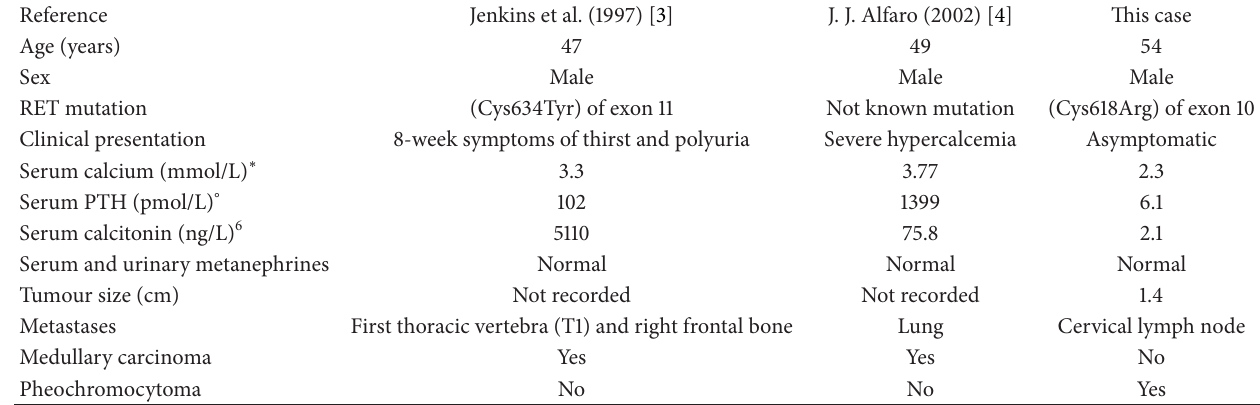
Table 1: Cases of PCA in the setting of MEN-2A reported in the